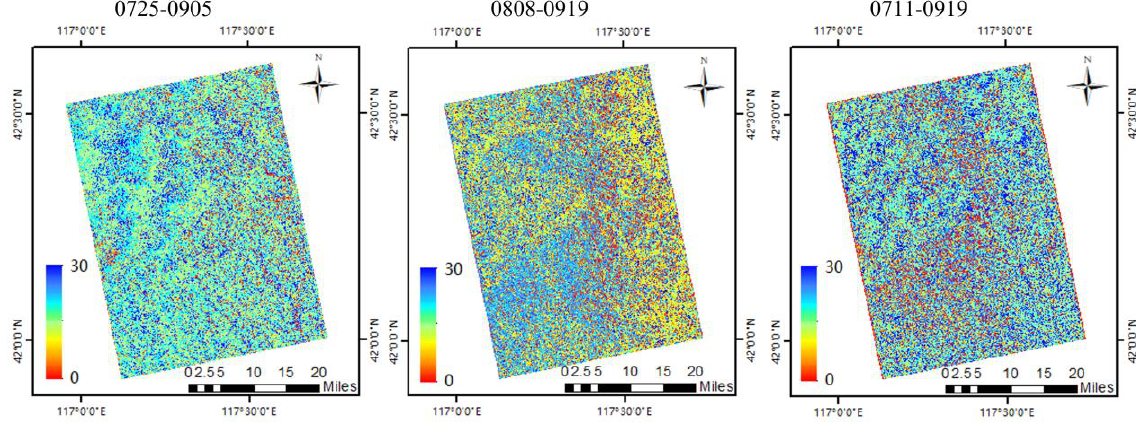
Figure 7. The inversion forest height